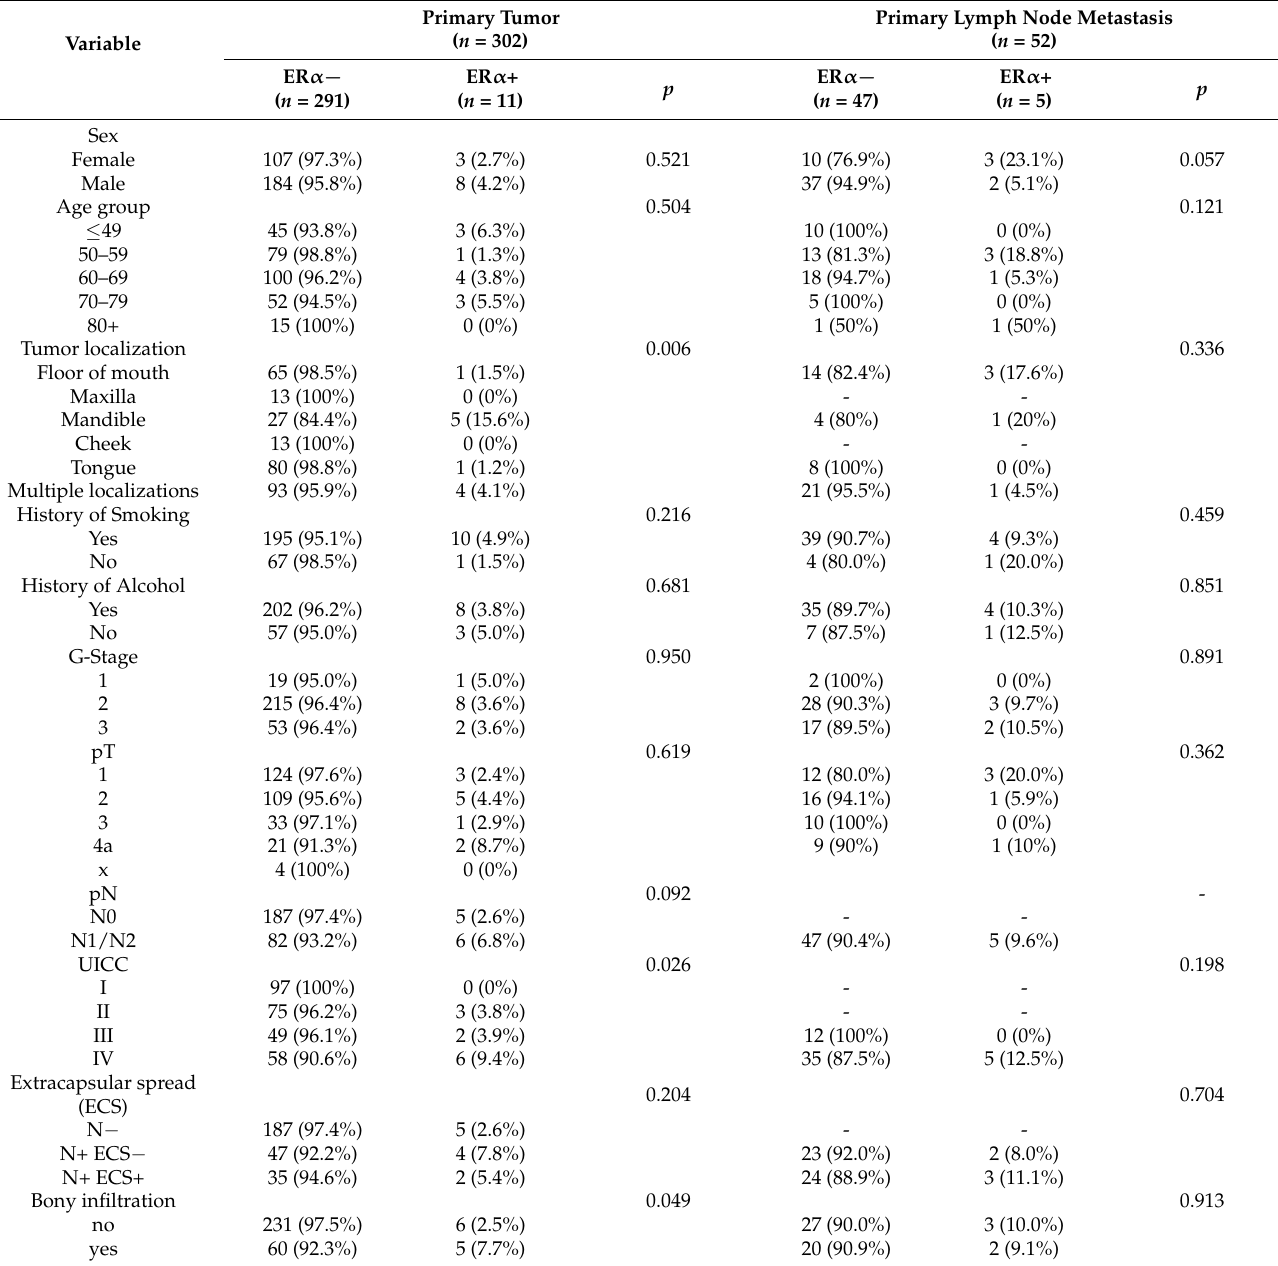
Table 1. Clinicopathological characteristics of the patient cohort in relation to the analysis of ER α expression in the primary tumor and lymph node